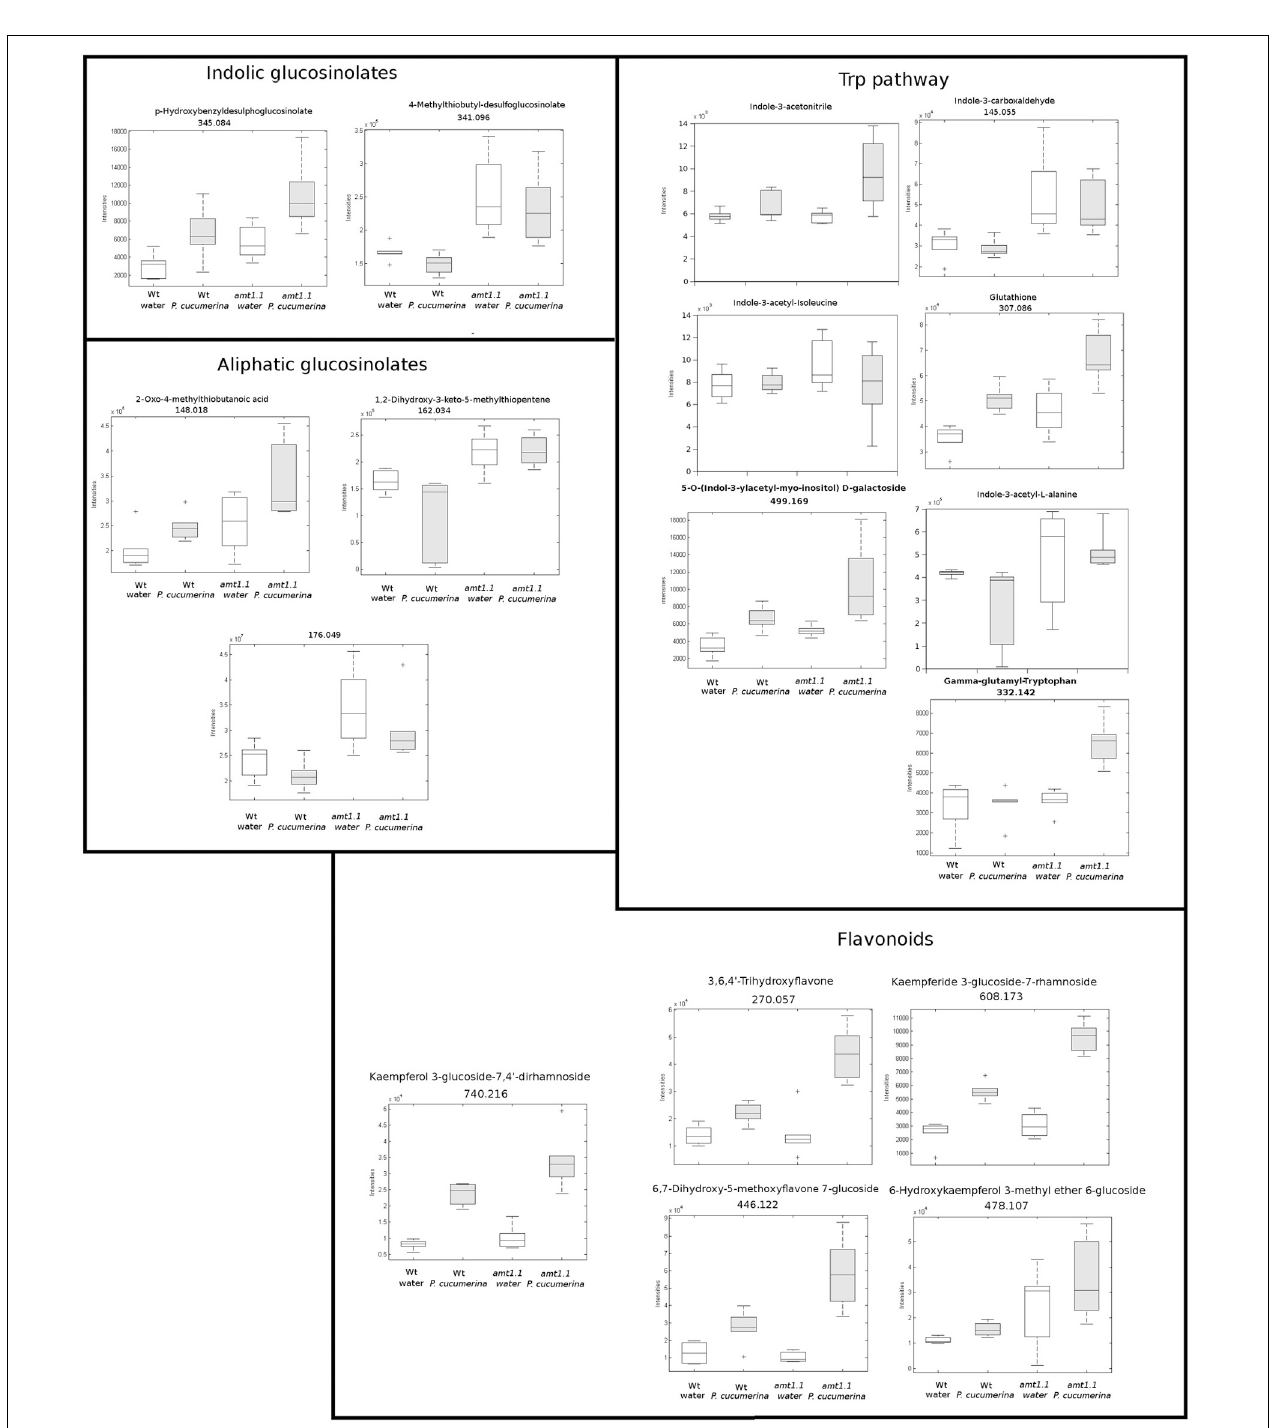
FIGURE 9 | Profile of the main hits in the overaccumulated compounds upon P. cucumerina infection in amt1.1 compared with Col3-gl1 . Two week old Col3-gl1 and amt1.1 were infected as described in Figure 1 . After 48hpi plants were processed for relative quantification analysis by HPLC-QTOFMS data. The concentration of the metabolites was determined in all the samples by normalizing the chromatographic area for each compound with the dry weight of the corresponding sample. The compounds were tentatively identified using the exact mass criteria using the METLIN and Massbank databases. Those compounds